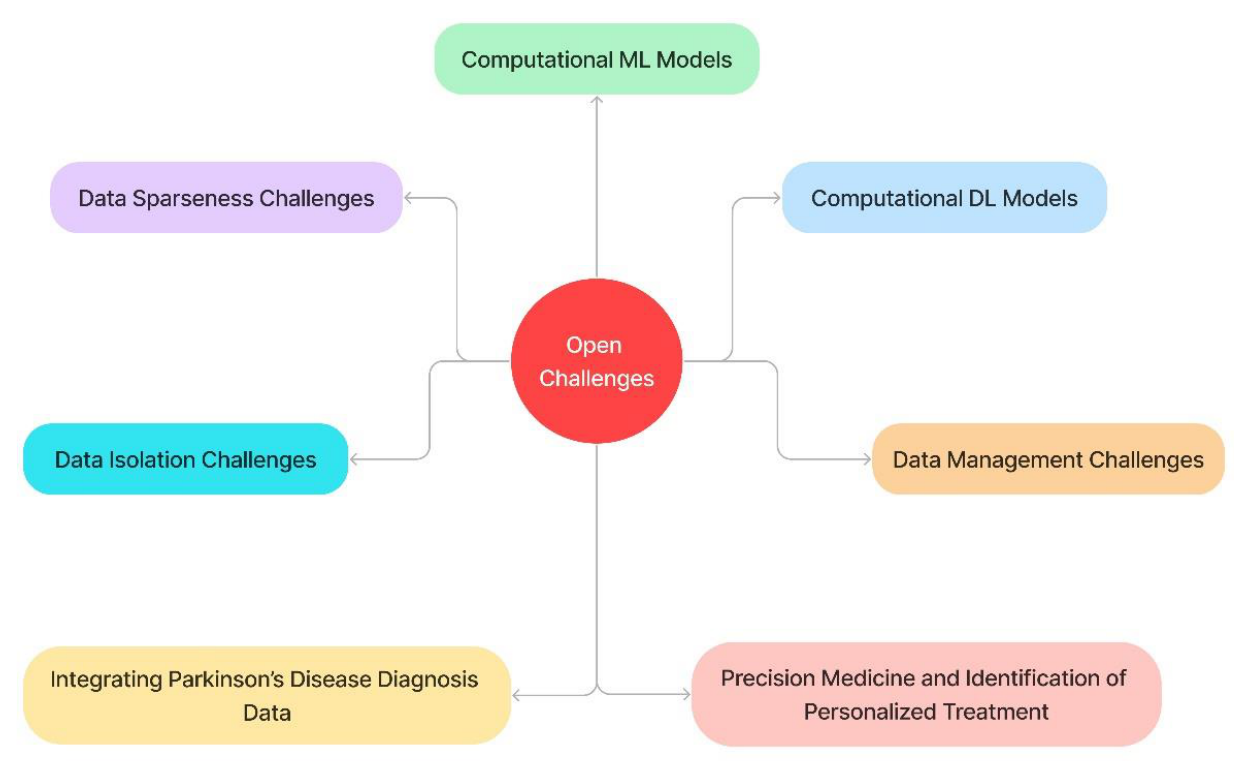
Figure 7. Open challenges for Parkinson’s disease Figure 7. Open c hallenges for Parkinson’s disease diagnosis.